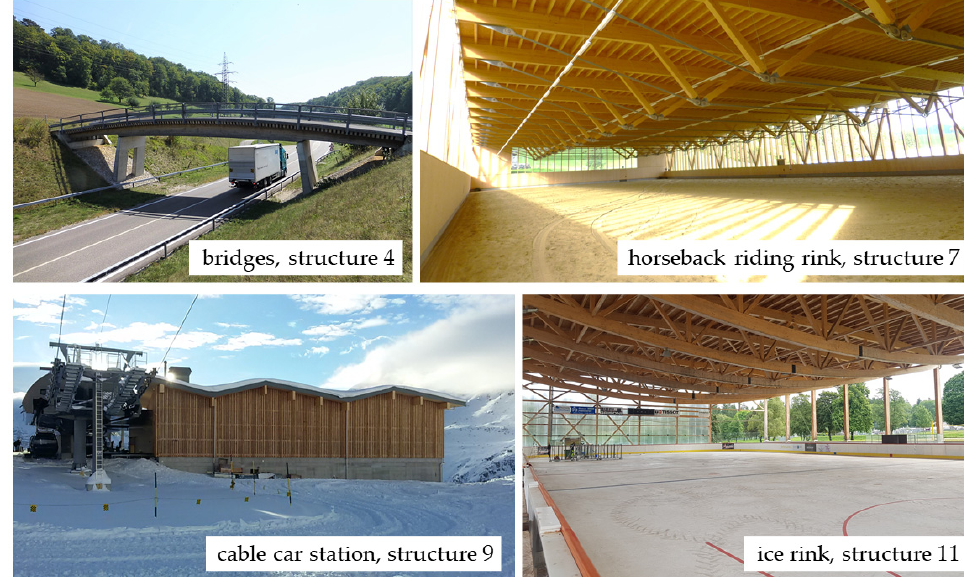
Figure 7. A selection of the 12 monitored structures: the Horen bridge, the horseback riding hall, the cable car station in Nätschen, and the ice rink in Le Locle.